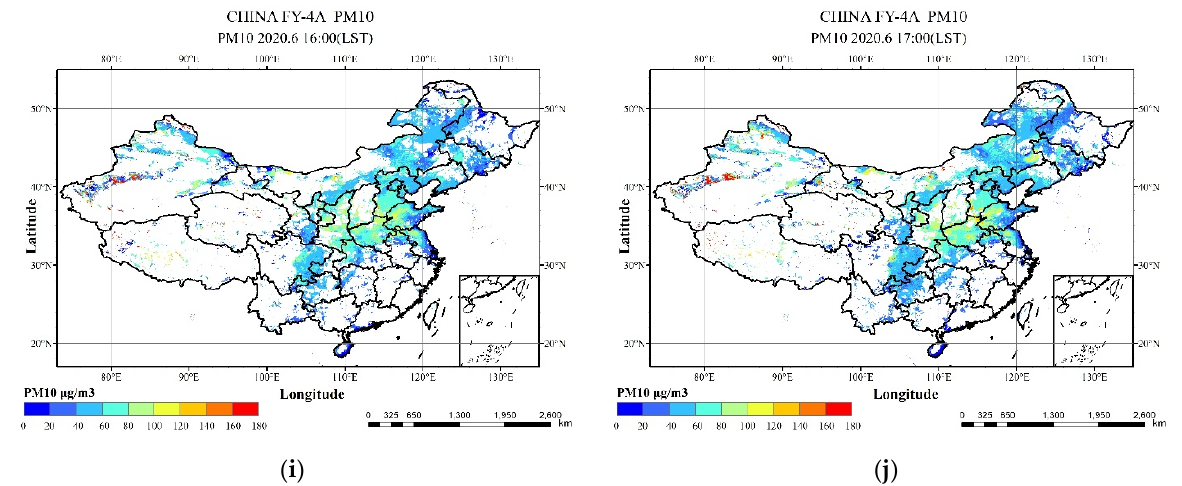
Figure 6. Average hourly PM 10 concentration on 5–6 and 9–10 June 2020, 8:00–17:00 (LST), from ( a ) to ( j ).